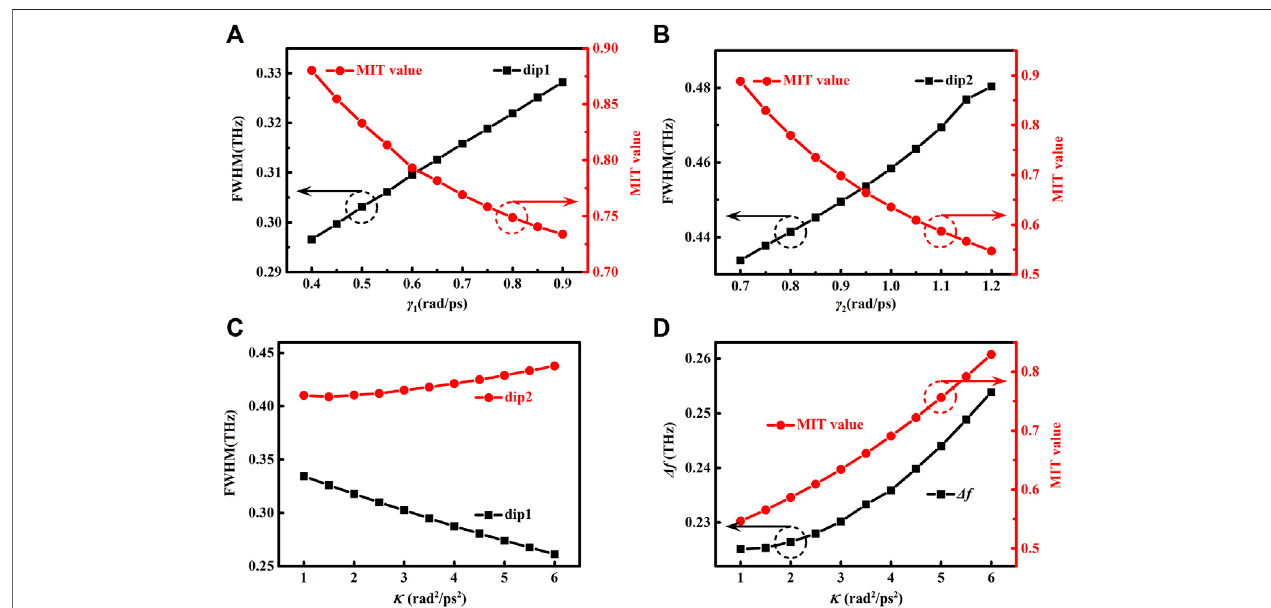
FIGURE4|(A) In fl uenceof γ 1 ontheFWHMofdip1andthevalueoftheMITwindow. (B) In fl uenceof γ 2 ontheFWHMofdip2andthevalueoftheMITwindow. (C) In fl uence of κ on the FWHM of dip1 and dip2. (D) In fl uence of κ on Δ f and the value of the MIT window.